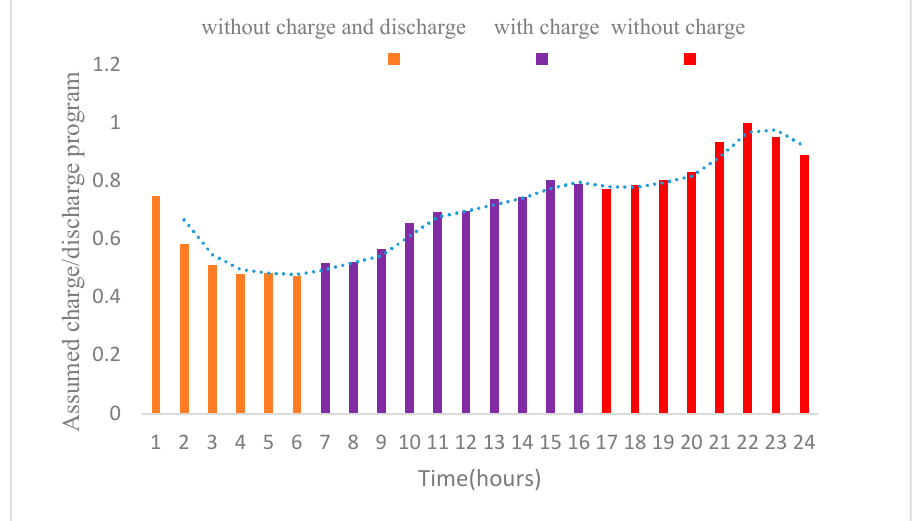
Figure 8. Charging/discharging programs of vehicles in the studied system. It should be noted that the time of entry and exit of vehicles to the charging station is randomly generated according to the distribution function according to the load curve.